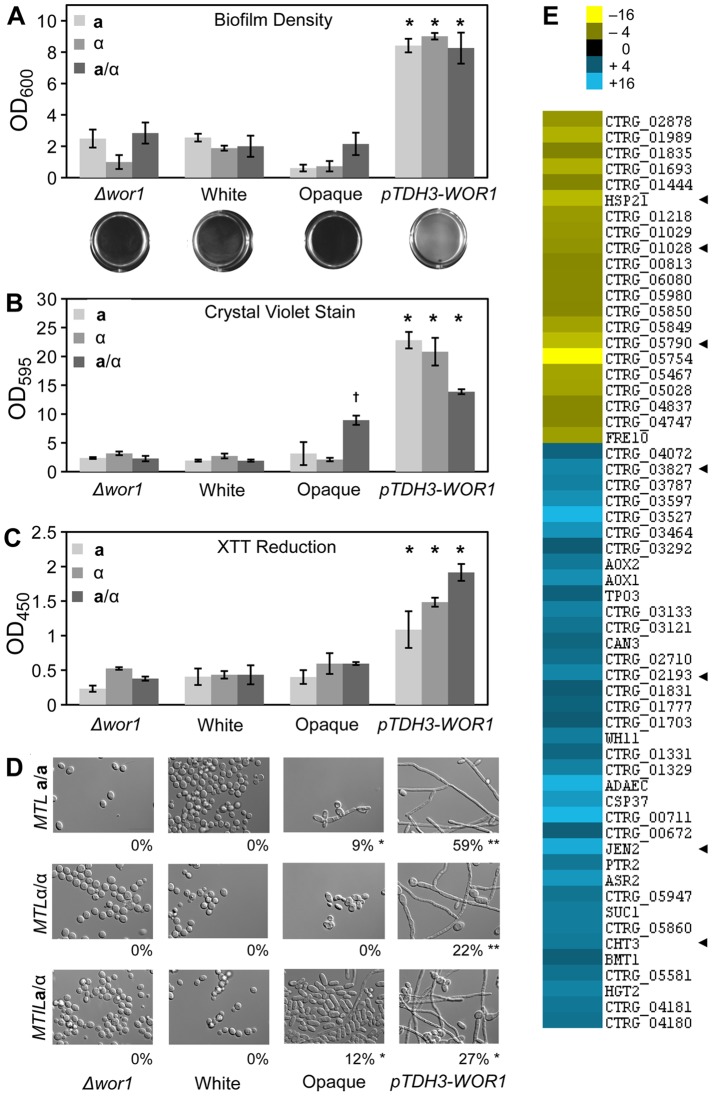
Biofilm formation is induced by WOR1 overexpression in C. tropicalis.(A) Quantification of cells adhering to a 12-well polystyrene dish following a 48-hour incubation in Lee's medium. Representative images of wells appear below the corresponding strains. Data from three experimental replicates, error bars indicate SD. * = p<0.001 when compared to Δwor1, white, and opaque strains. (B, C) Quantification of biofilm production by colorometric assays. (B) Beta-glucan content was determined by crystal violet staining. (C) Cellular viability was measured by formazan formation upon XTT reduction. Each biofilm experiment includes three or more replicates, error bars indicate S.D. * = p<0.001 when compared to Δwor1, white, and opaque strains. † = p<0.001 when compared to Δwor1, white, and pTDH3-WOR1 strains. (D) Morphology of adherent cells taken from (A). Percentage of filamentous cells indicated below image. Scale bars = 20 µm. Statistical significance was determined using Mann-Whitney pair-wise tests. ** = significantly different from opaque, white, and αwor1 strains, p<0.001. * = significantly different from white and αwor1 strains, p<0.001. (E) Genes induced in MTL
a/a
WOR1 overexpressing cells under biofilm conditions. Heat map shows relative expression changes between pTDH3-WOR1 (CAY3853) and opaque (CAY3378) strains in the adherence to plastic biofilm assay. Data set was filtered for genes with a fold-change greater than 4 and clustered by Average Linkage Clustering. Data shows average of two independent biological replicates. Arrowheads highlight C. albicans homologs that are biofilm regulated.